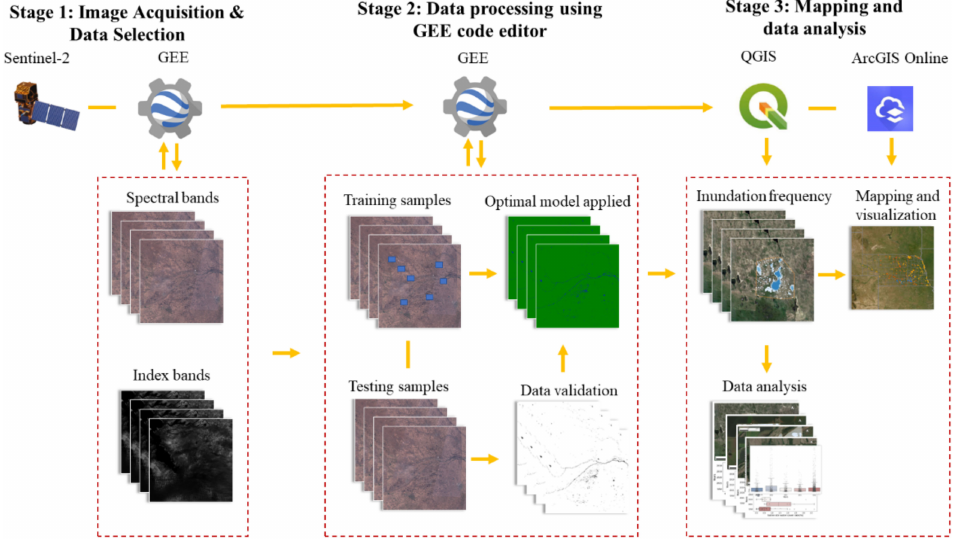
Figure 2. Research workflow to calculate inundation areas in each CE